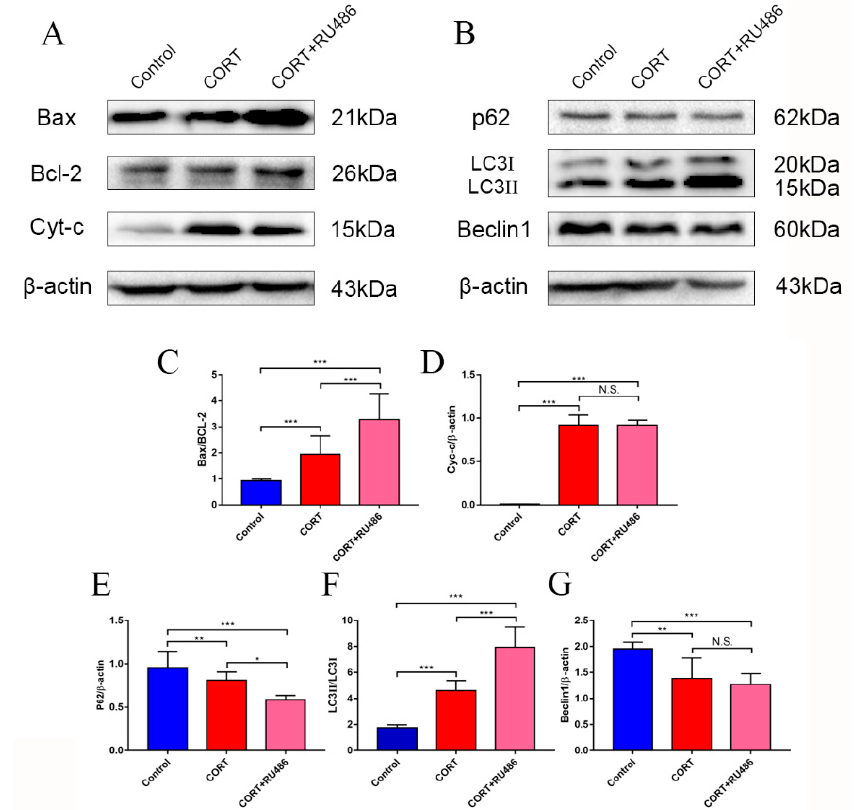
Figure 8. The relevant expression of autophagy markers in HT22 cell lysates after cortisol treatment for 3 h as assessed by western blotting and relative density analyses. ( A , B ) Bax, Bcl-2, Cyt-c, p62, LC3, beclin1, and β -actin expression in each group. Expression levels were quantitated by measuring band intensities using Image Lab software. The graphs indicate densitometric analyses using the expression ratios of ( C ) Bax / Bcl-2, ( D ) Cyt-c / β -actin, ( E ) p62 / β -actin. ( F ) LC3II / LC3I, and ( G ) beclin1 / β -actin. The results are expressed as the mean ± SD (n = 3) in each independent experiment analyzed by one-way analysis of variance. NS: not significant; * p < 0.05; ** p < 0.01; *** p < 0.001.